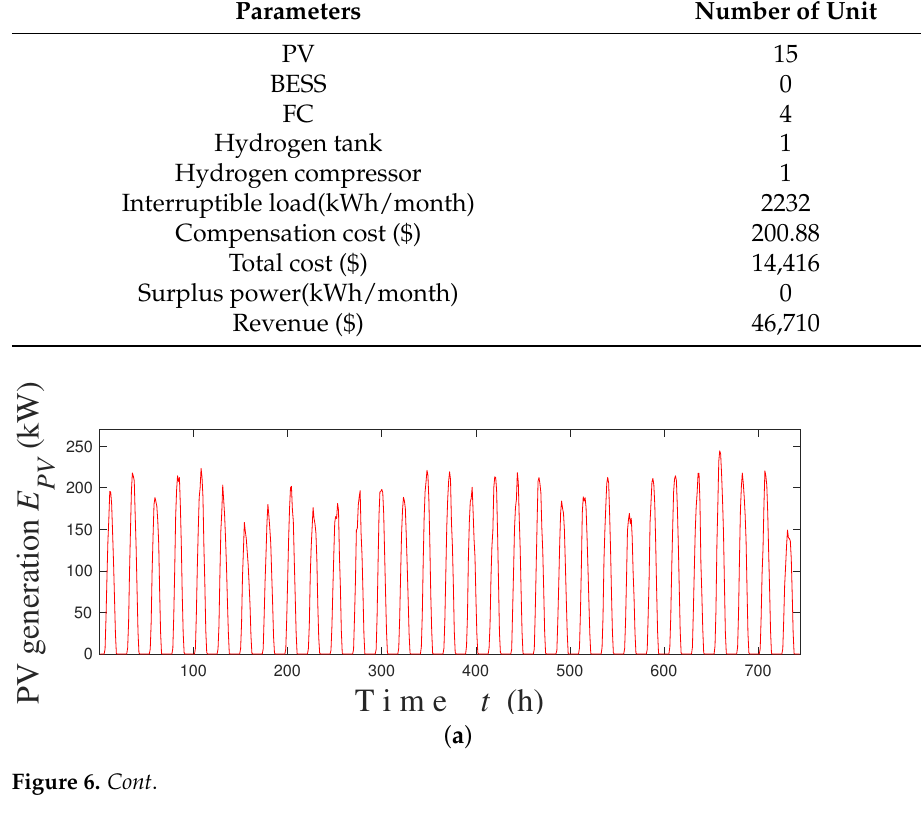
Table 14. Simulation results of case 3.